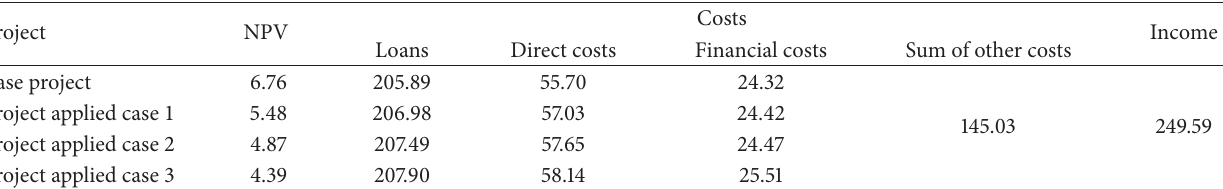
Table 2: Cash flow for each case.